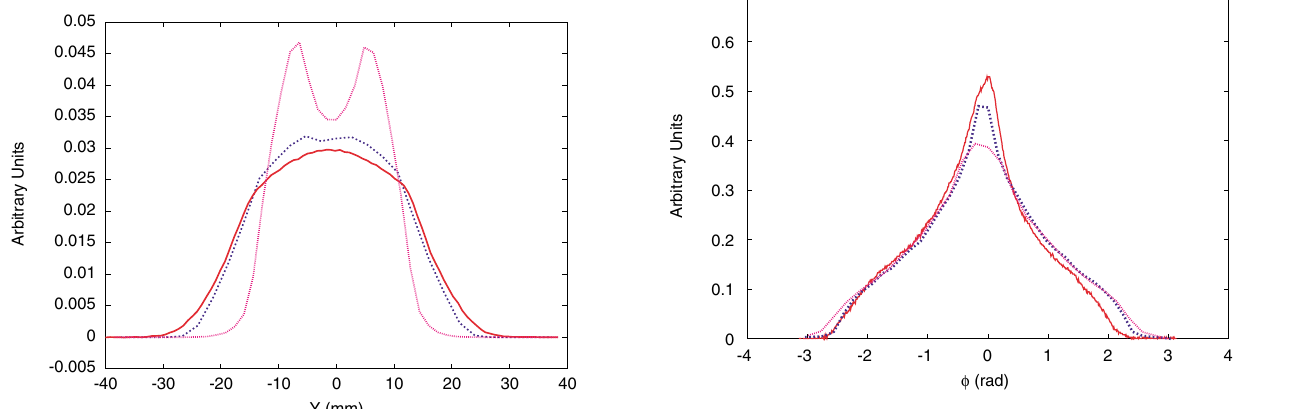
FIG. 1. (Color) Benchmark of vertical experimental profile measurements with PIC simulations. The solid (red) curve is the experimental profile. The dotted (blue) curve is the PIC result with space charge. The (pink) dashed line is the PIC result without space charge.